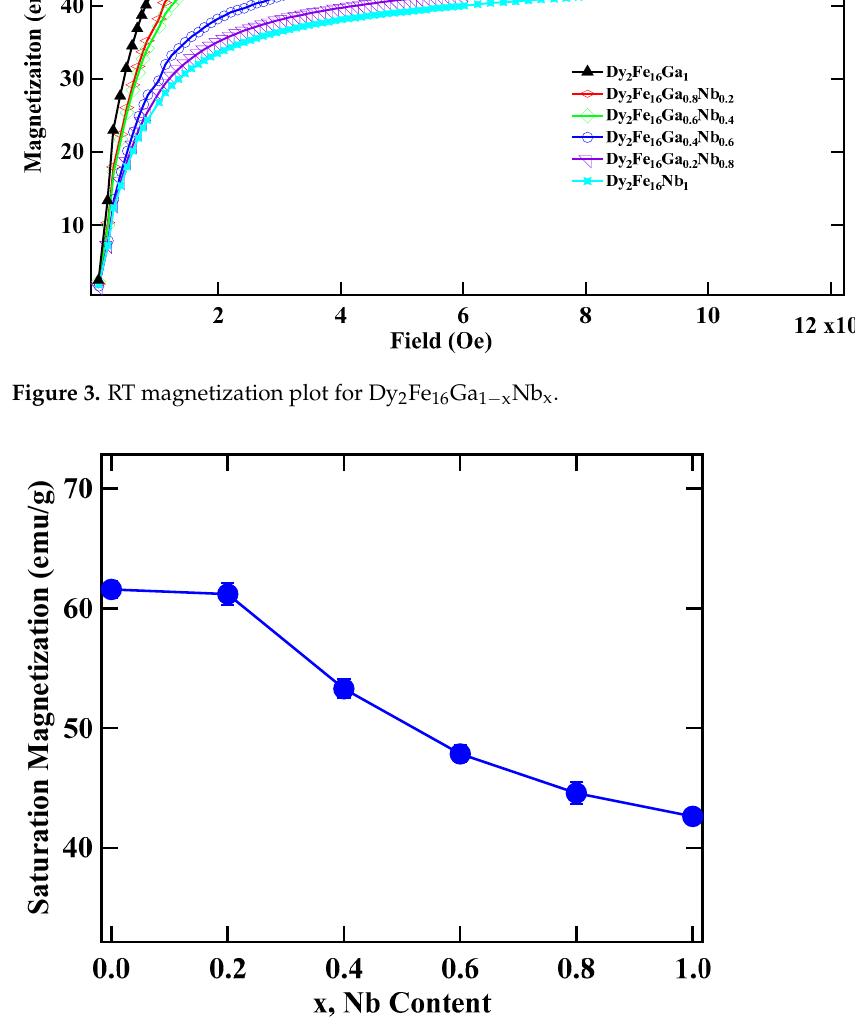
Figure 4. Room temperature (RT) saturation magnetization, Ms , as a function of x , Nb content. The Curie temperature, Tc , of Dy 2 Fe 16 Ga 1 − x Nb x as a function of Nb content is shown in Figure 5. It is observed that Curie temperature of Dy 2 Fe 16 Ga 1 − x Nb x alloys increases with increase in Nb concentration from 488 K ( x = 0.00) to a maximum of 523 K ( x = 0.6) and then decreases to 460 K ( x = 1.00). The achieved Tc for Dy 2 Fe 16 Ga 0.4 Nb 0.6 is 35 K higher than that of Dy 2 Fe 17 Ga 1 and 153 K higher than that of Dy 2 Fe 17 [10]. In general, Tc in rare-earth intermetallic compound is due to three kinds of exchange interactions, namely the 3d-3d exchange interactions, i.e., between the magnetic moment of the Fe sub-lattice (J FeFe ), 4f-4f exchange interaction, i.e., the interaction between the magnetic moment within the R sub-lattice (J RR ), and the inter sub-lattice 3d-4f exchange interaction (J RFe ). It is reported that the Tc increases with an increase in the J FeFe [33]. The interactions between the rare-earth spins (4 f -4 f ) are assumed to be weak and negligible compared to the